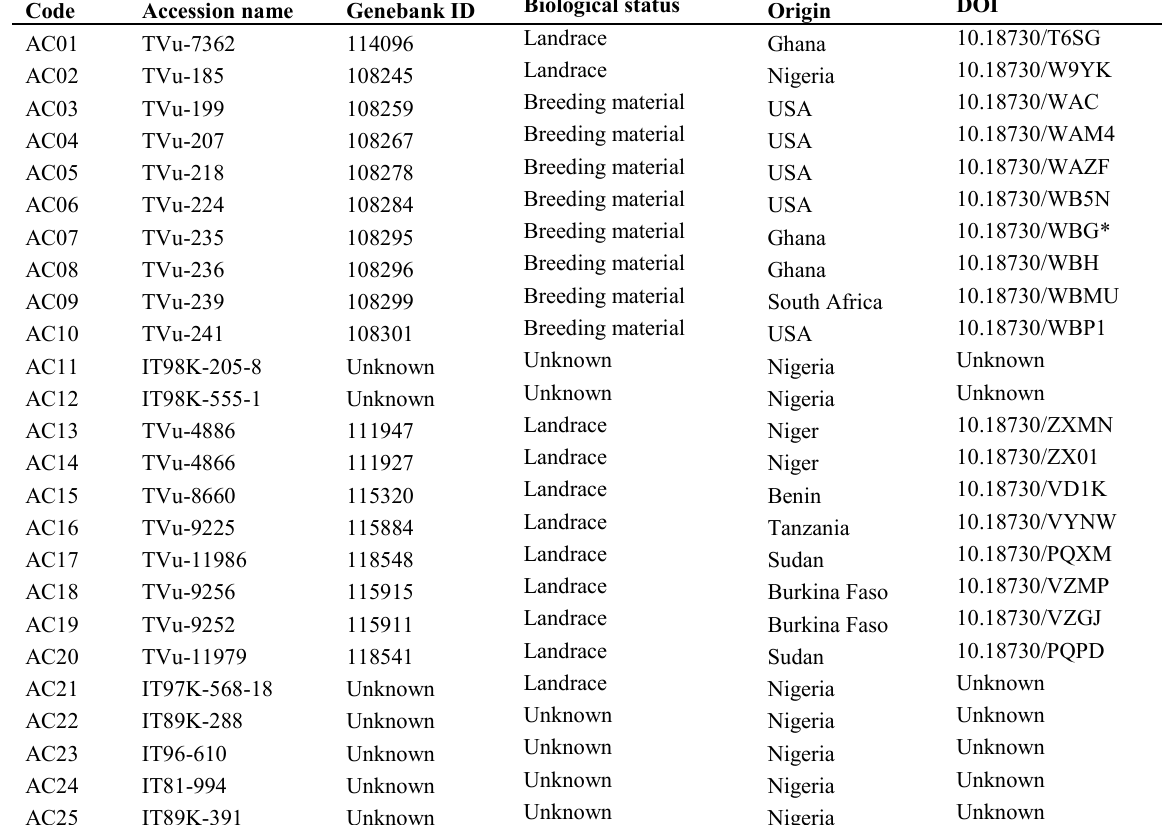
Table 1. List of accessions of cowpea used for variable expression of NCED1 under control (A) and drought stress (T)